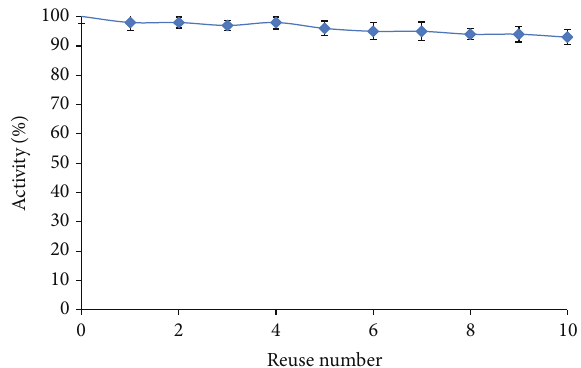
Figure 8: Operational stability of the immobilized